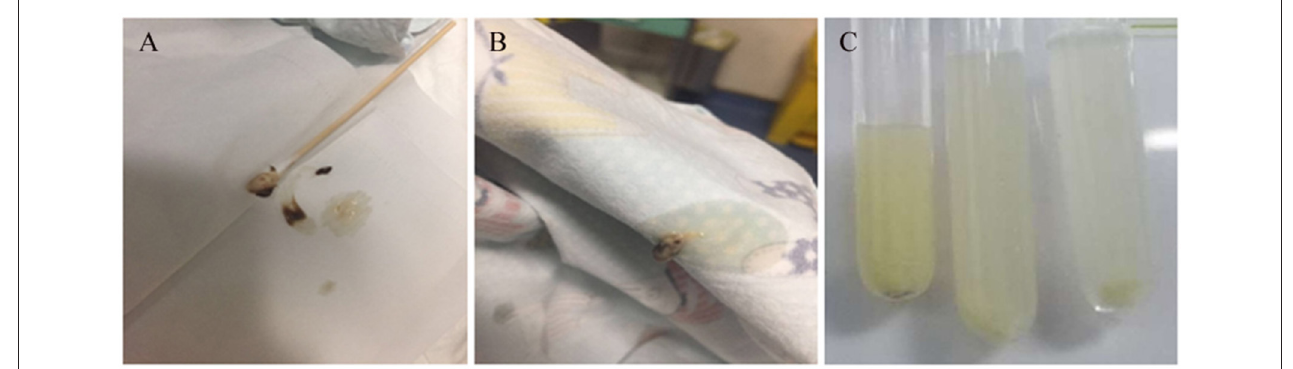
FIGURE 1 | Images of airway secretions or mucous exudates for cases 1 and 2. (A,B) Case 1, (C) Case